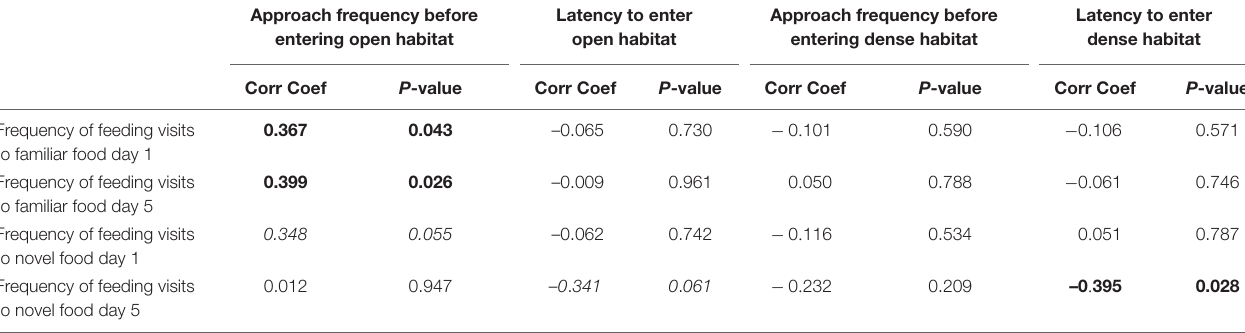
TABLE 4 | Correlation between rate of incorporation of novel food into the diet and spatial novelty